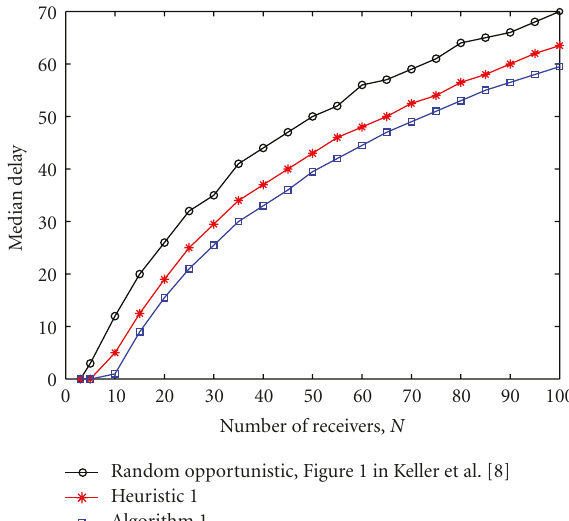
Figure 2: Median of decoding delay for the transmission of K = 100 packets to N = 3 to N = 100 receivers. Channel erasures are memoryless and occur with a high probability of p = 0 . 5 independently in every link. Algorithm 1, Heuristic 1 and random Heuristic [8] are compared with each